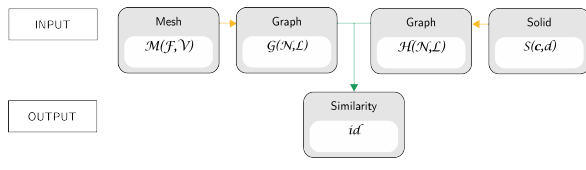
Figure 3. Methodological workflow for creating a match between a VI-SLAM mesh and a reference BIM library of solids. Graphs are extracted from both input types (yellow arrows), which are compared and matched based on similarity (green arrow).